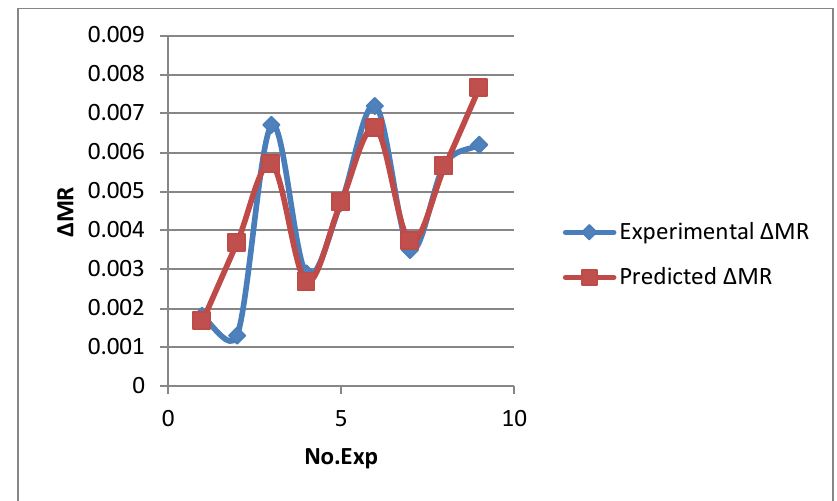
Fig. 7. Experimental and predicted